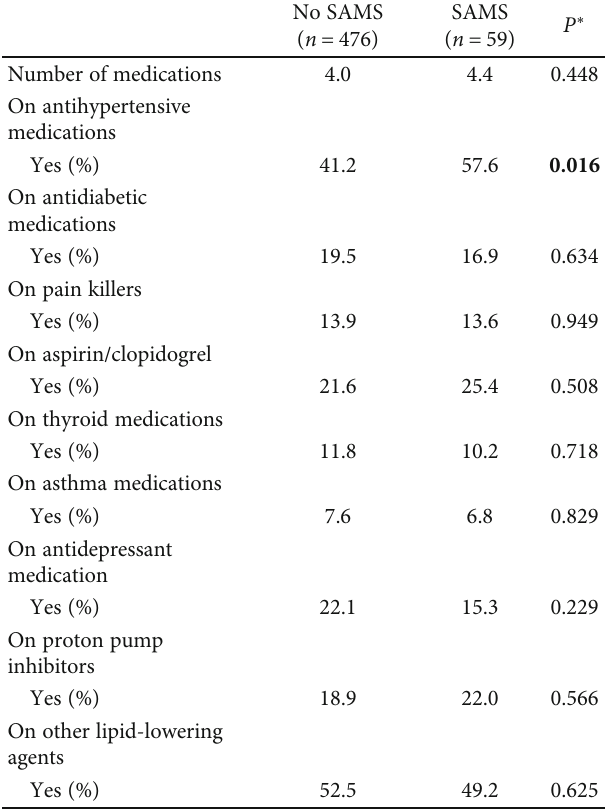
∗ P values represent the level of signi fi cance of the di ff erence between patients who have developed SAMS and non-SAMS patients, calculated using the chi-square test. For the numerical, an independent samples t -test was used to test